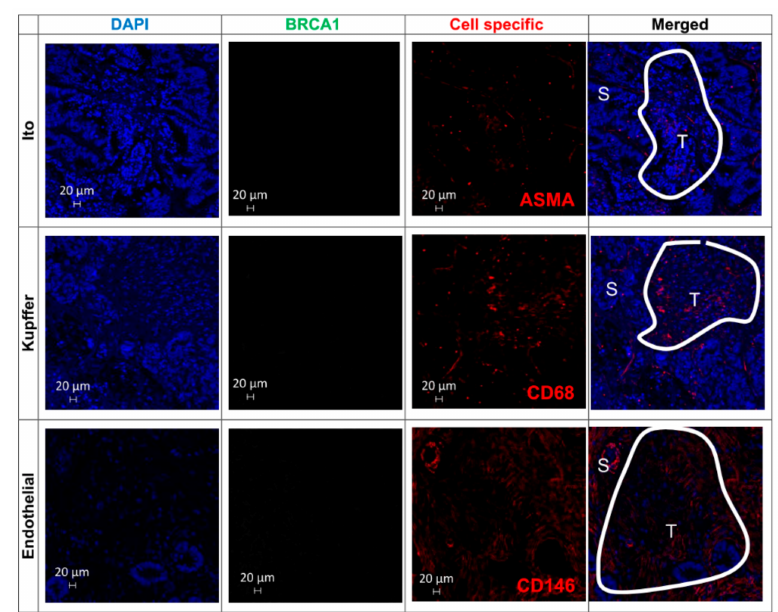
Figure 8. The BRCA1 protein is not expressed in all the TME cells from CRC liver metastases from Stage I patients (metachronous). BRCA1 expression on TMA samples on Ito, Kup ff er, and endothelial cells from human CRC liver metastases. White lines delimit the tumor cell tissue regions (T) from the non-tumoral cell stromal area